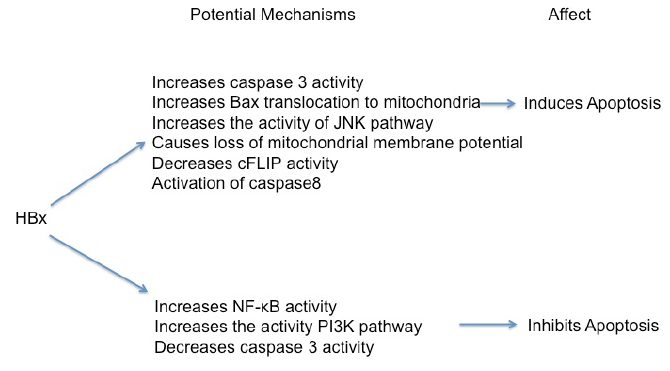
Figure 3. Potential mechanisms by which HBx induces or inhibits apoptosis in different cells. See text for